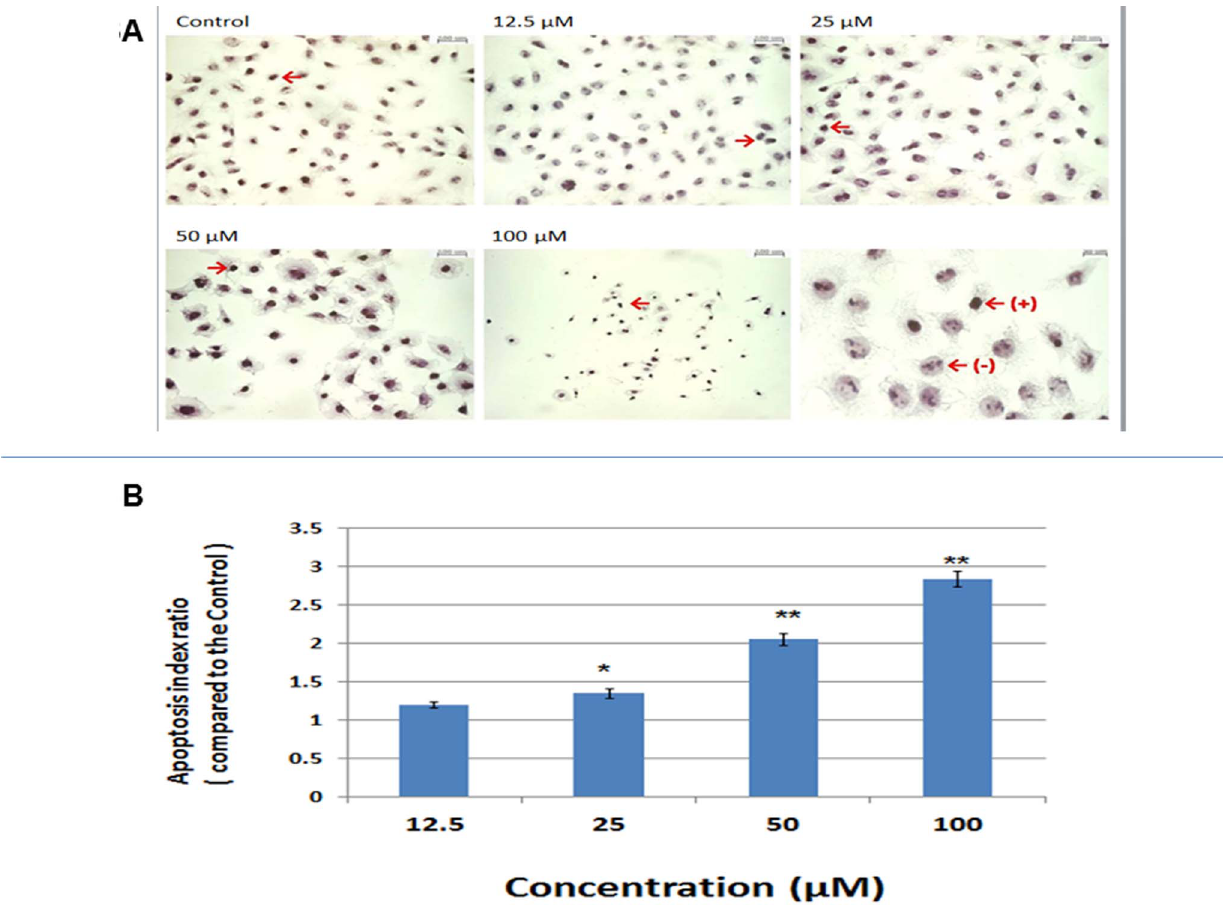
Figure 3. Celecoxib induced apoptosis in CGCCA cells. CGCCA cells were treated with the indicated concentrations of celecoxib for 2 days. (A) TUNNEL assay was used to identify apoptotic cells under different concentrations of celecoxib. Cell morphology and the nuclei were revealed by Harris modified hematoxylin solution counter-staining. The arrows indicated cells positive ( + ) for TUNNEL assay. The examples of positive ( + ) and negative (–) cells for TUNNEL assay were shown in the right lower corner panel (B) The apoptotic index of CGCCA cells treated with different concentrations of celecoxib. Each value is a mean 6 SD of 3 to 5 determinations. *p , 0.05, **p , 0.001 (versus control).